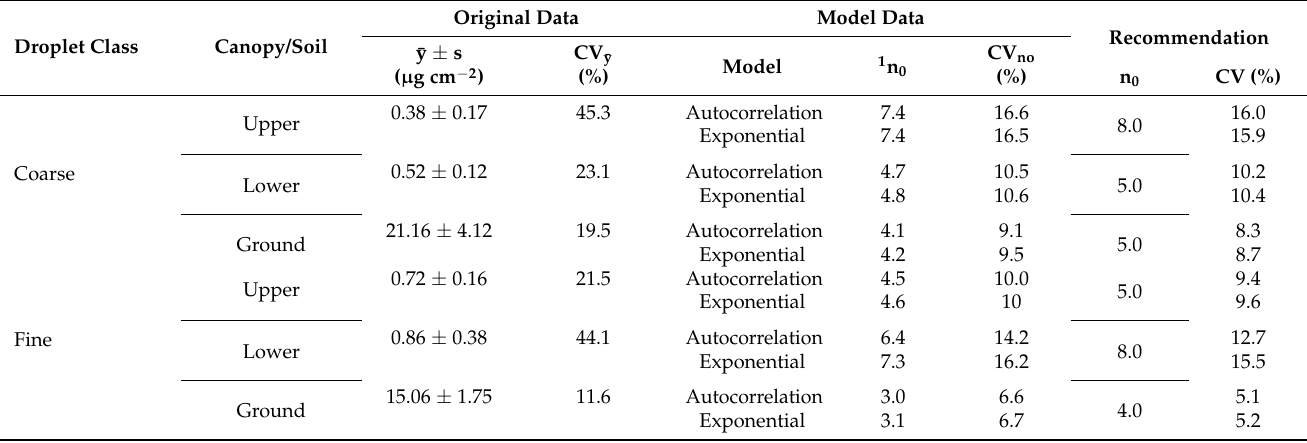
Table 2. Optimal sample size for spray deposition on coffee leaves and soil runoff as a function of droplet size and collection position in the